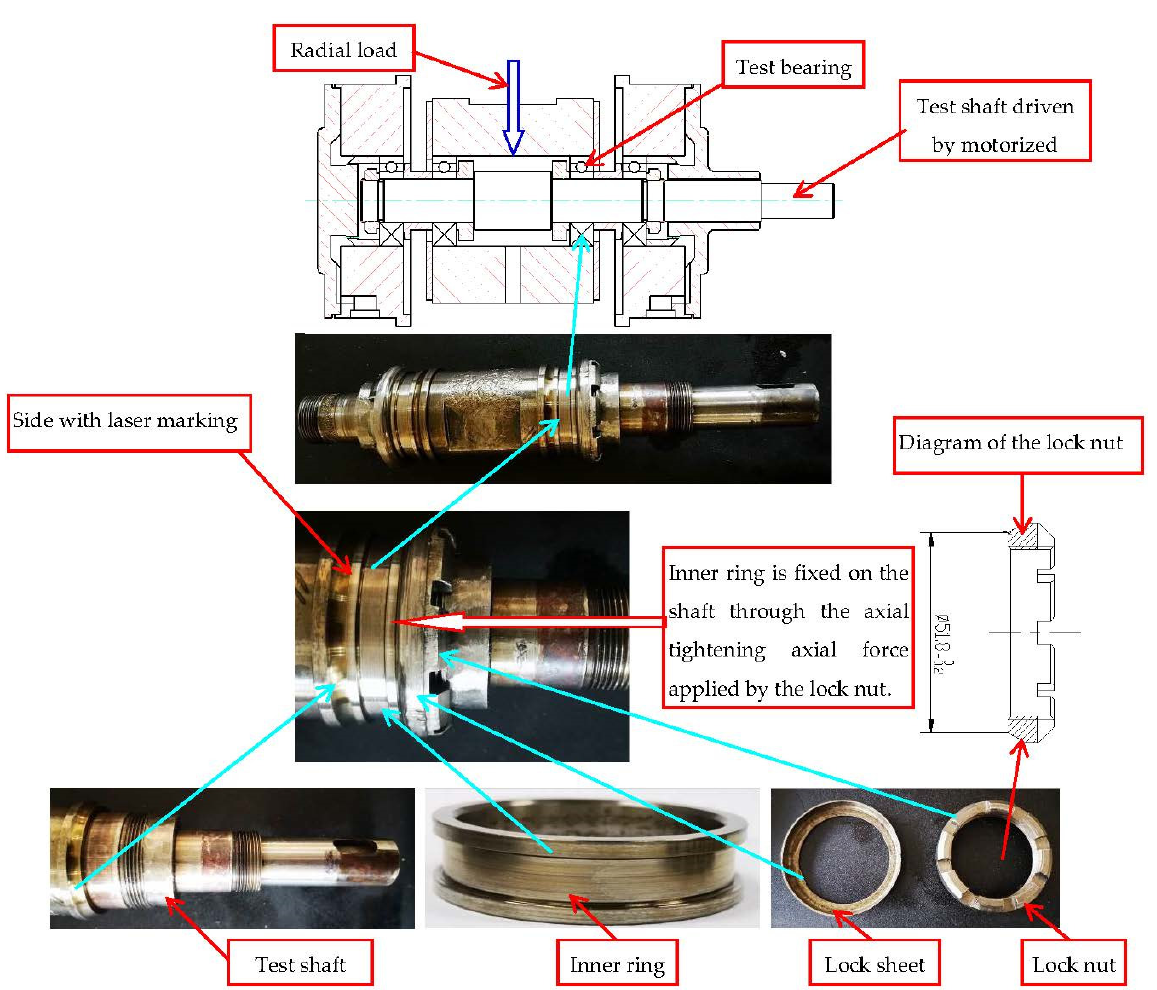
Figure 3. Installation morphology of the inner ring and assembly schematic diagram of the bearing on the test rig.